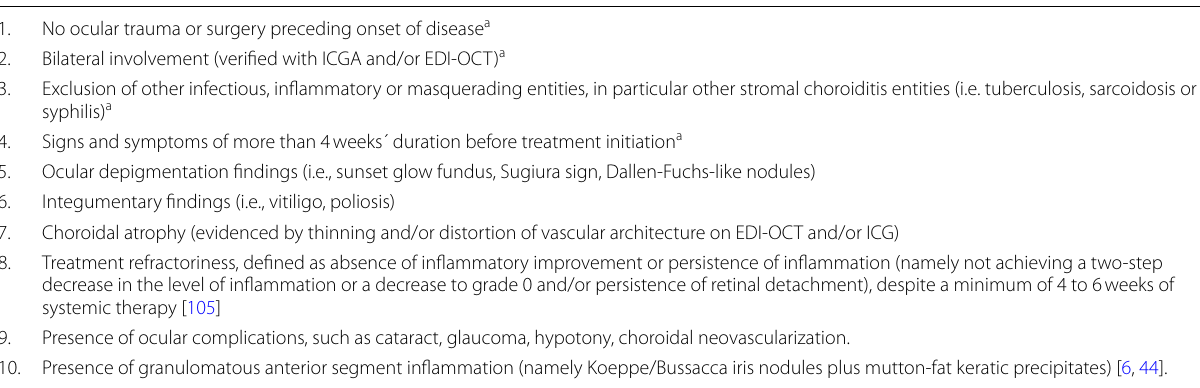
Table 3 Diagnostic criteria for chronic recurrent Vogt‑Koyanagi‑Harada